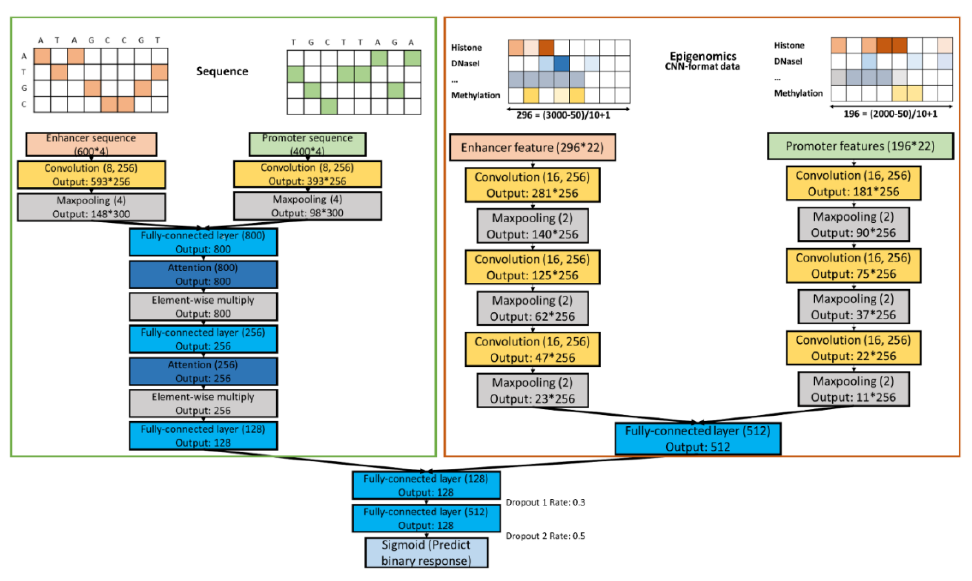
Figure 3. Combined model structure with the sequence and epigenomic models.